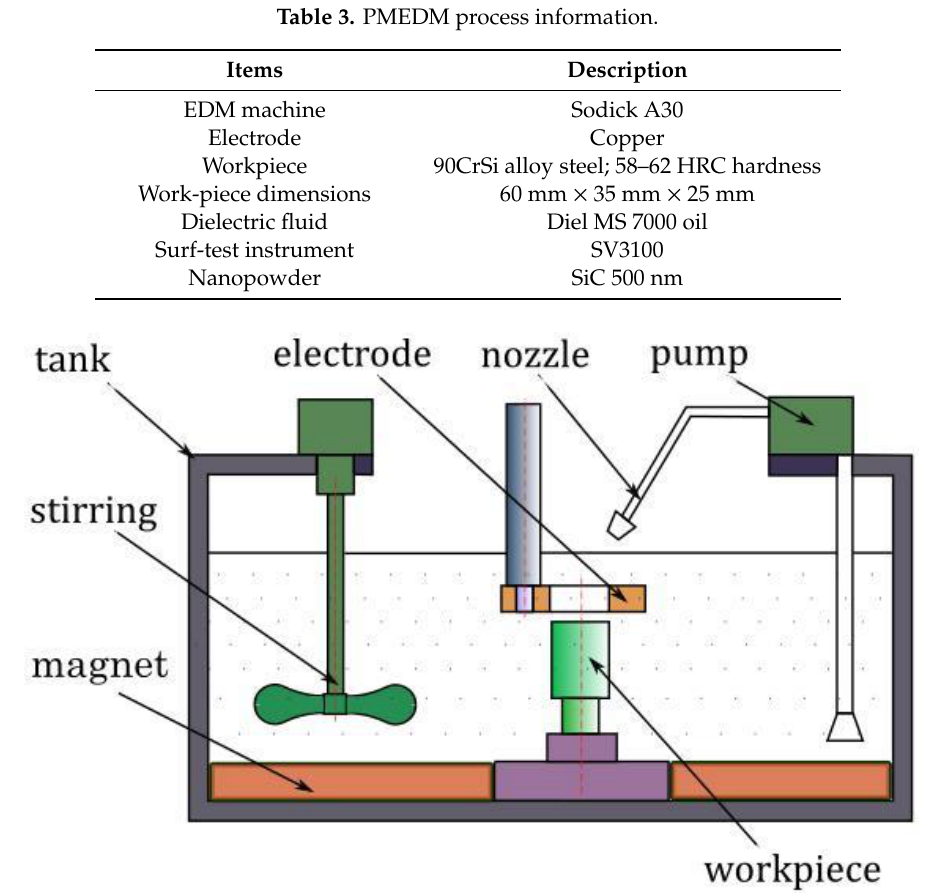
Figure 4. Experimental setup.